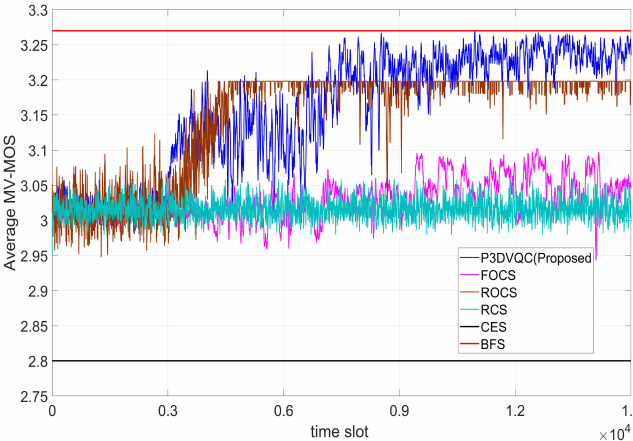
Figure 6. Average MV-MOS by different kinds of caching schemes.